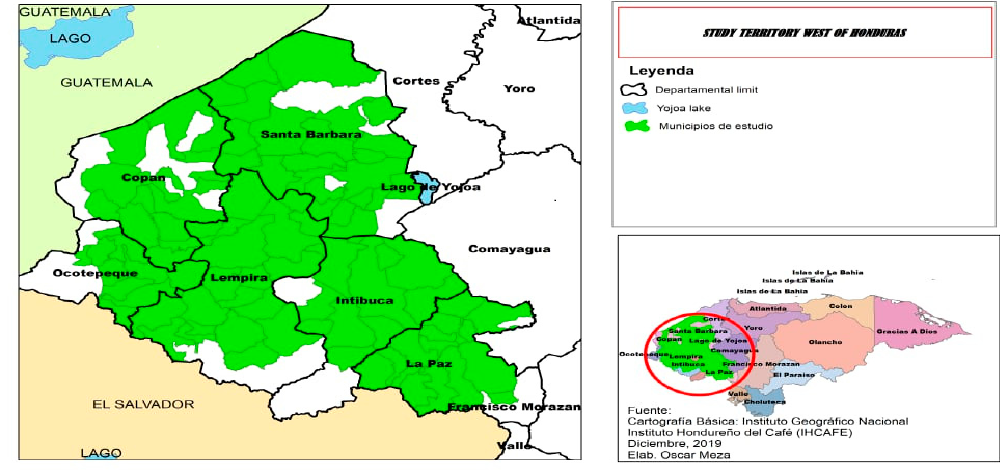
Figure 2. Study area, mapped by the author using Arc Gis/2018.